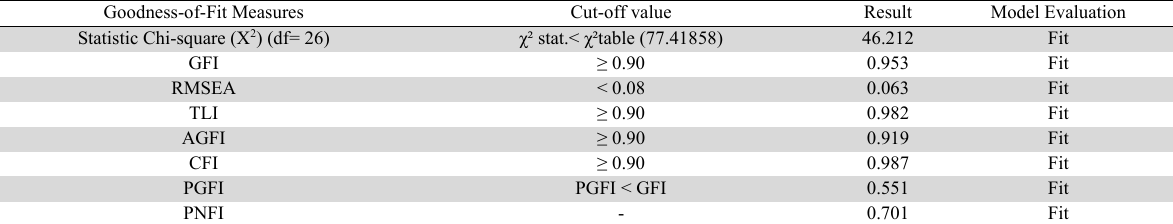
Goodness of fit test results Goodness-of-Fit Measures Cut-off value Result Model Evaluation Statistic Chi-square (X 2 ) (df= 26)